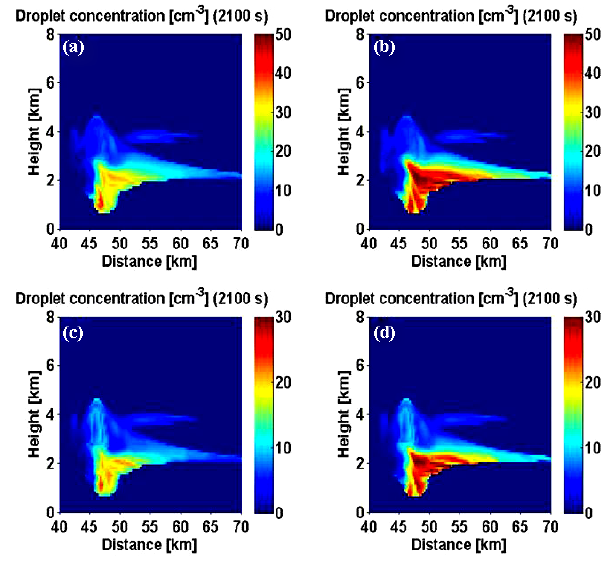
Figure 7. Fields of droplet concentration at t = 2100s in (a) E100- S-0.5, (b) EN100-S-0.5, (c) E100-S, and (d) EN100-S simulations.